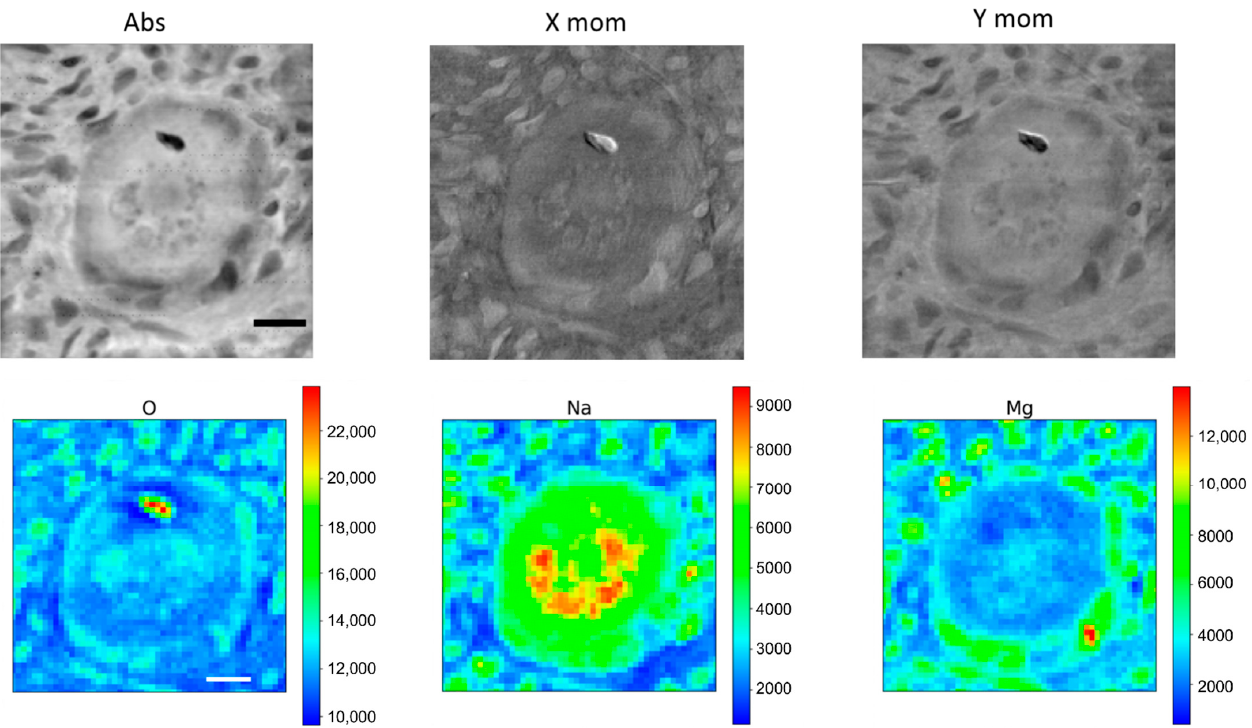
Figure 6. Absorption (Abs) and differential phase contrast in X (X mom) and Y (Y mom) images of primary oocyte in an ovarian tissue, depicted with the corresponding XRF maps of O, Na, and Mg. The maps were collected at 1.5 keV over an area of 70 µm × 70 µm (STXM images) or 60 µm × 60 µm (XRF maps) with 300 nm and 1 µm step sizes, respectively, with a 7 s/pixel acquisition time for XRF. Scale bar is 10 µm.